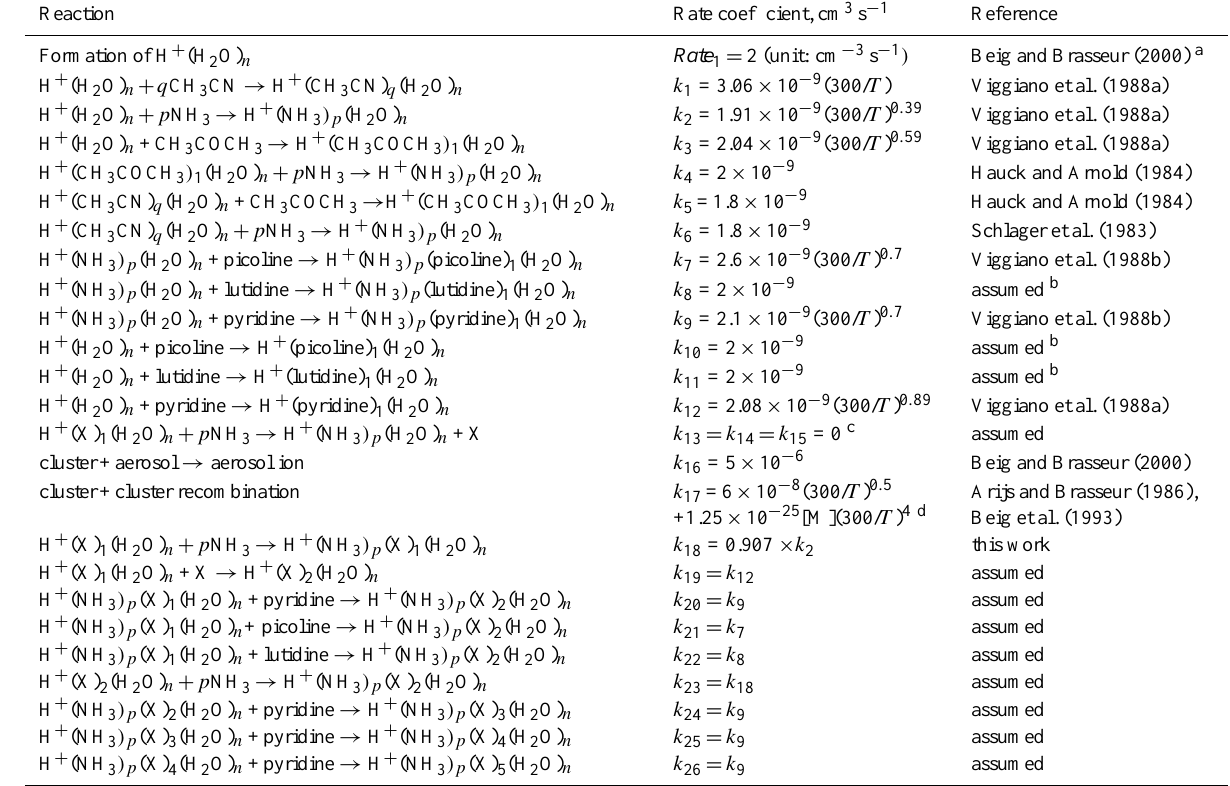
Table 1. Rate coefficients for the reactions used in Model A and Model